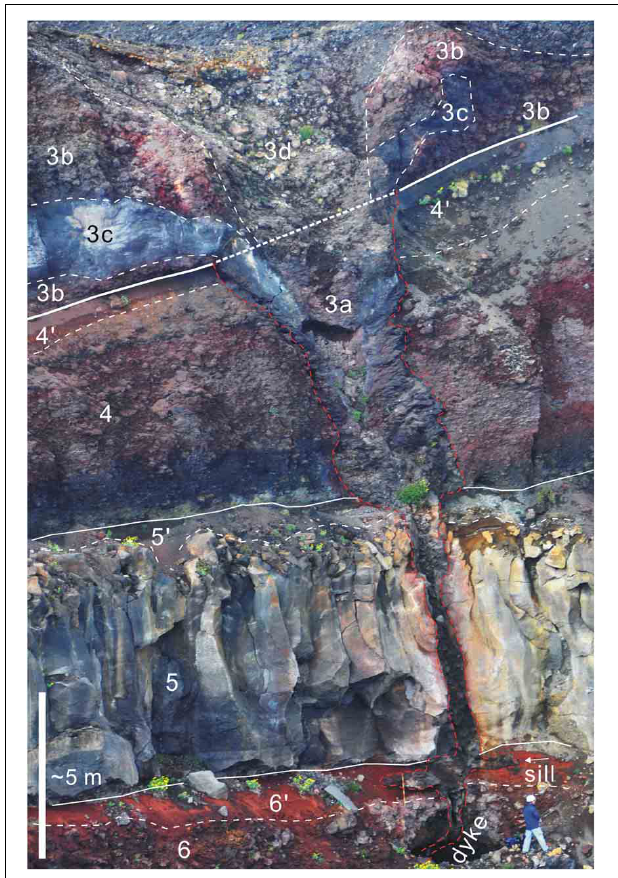
FIGURE 5 | Close-up view of the feeder system on the southern wall of the 1809 crater A (outcrop A–S). The outlines of the feeder system are highlighted with red lines. White solid lines show the unit boundary. Dashed lines show the sub–boundary in each unit. Boundary between Units 3b and 4 represents the ground surface at the beginning of the 1809 eruption. See text for lithological details.